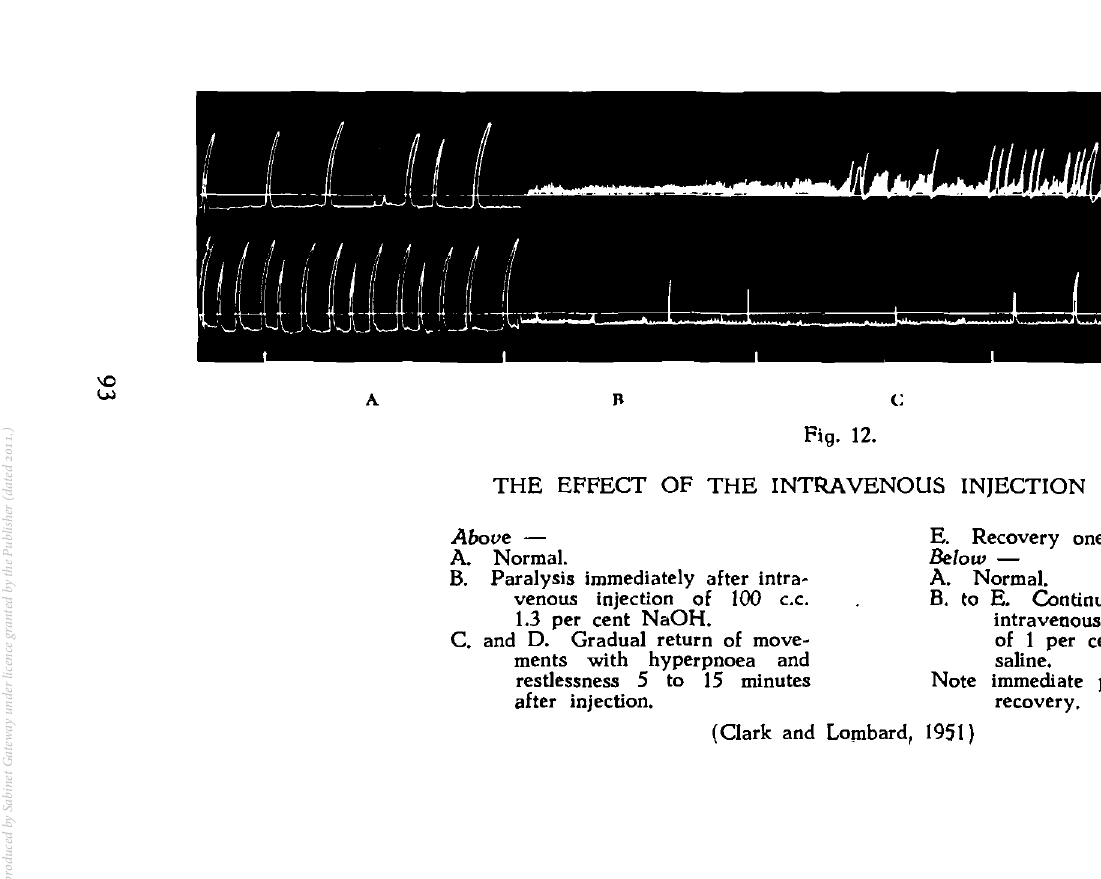
THE EFFECT OF THE INTRAVENOUS INJECTION OF ALKALI Above - A.